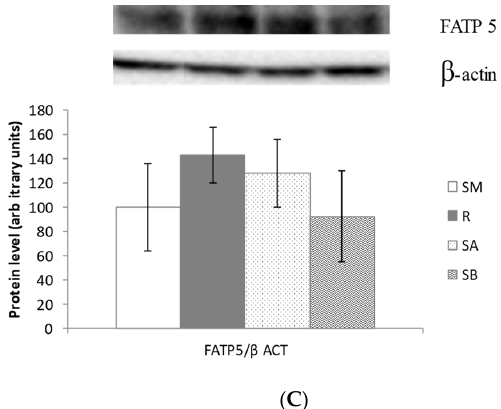
Figure 5. Effects on fatty acid uptake of MetS rats (MS, n = 10), rats fed with wheat control diet (WC, n = 10), wheat and oat control diet (OC, n = 10), A snack (SA, n = 10), and B snack (SB, n = 10). ( A ) Fatty acid uptake involved genes mRNA levels, ( B ) FATP2 protein levels and ( C ) FATP5 protein levels. Values are expressed as mean ± SEM. Values not sharing a common letter are significantly different ( p < 0.05). In the case of acsl1 gene expression, p value for the comparison between OC and SA vs. SB is p < 0.01. No changes were observed in glut2 and glut5 gene expression or protein level (Figure 6A–C)